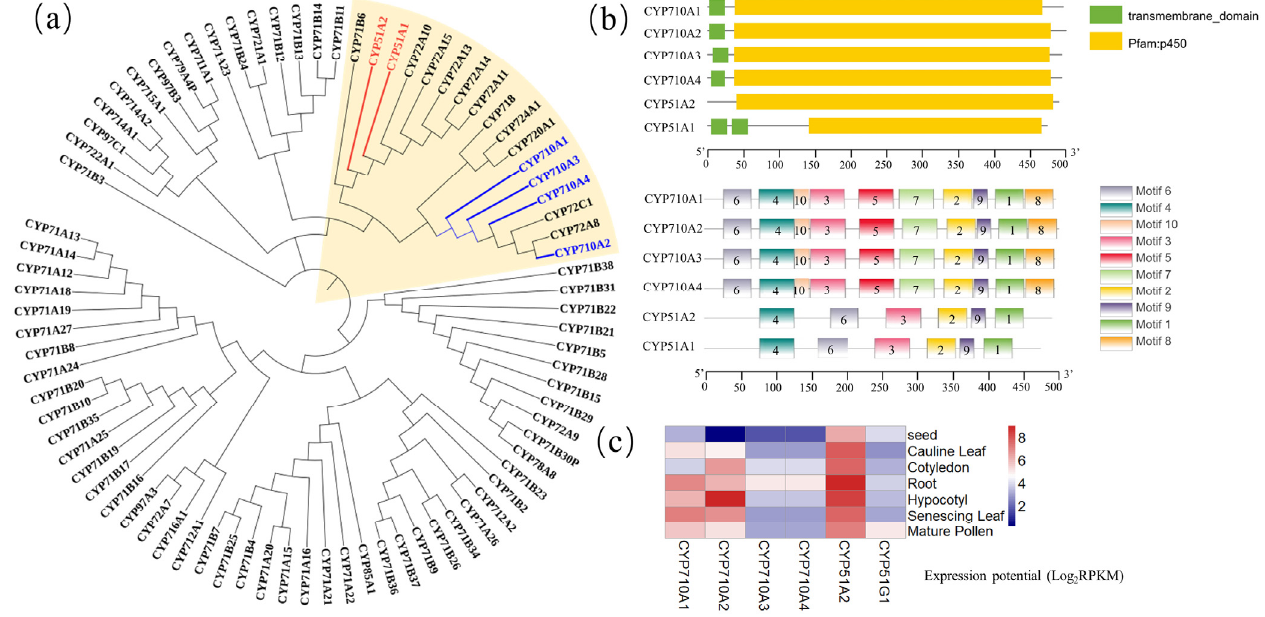
Figure 3. ( a ) Phylogeny of the CYP gene superfamily in A. thaliana . The unrooted phylogenetic tree of 81 CYP genes in A. thaliana was constructed by MEGA7.0 with the neighbor-joining (NJ) method. In the phylogenetic tree, CYP710 is marked in blue, CYP51 is marked in red, CYP710 and CYP51 cluster into one clade is marked in yellow. ( b ) The domain and motif of CYP710 and CYP51 were analyzed by NCBI and MEME, respectively. ( c ) Expression profile of CYP710 and CYP51 in different tissues of A. thaliana